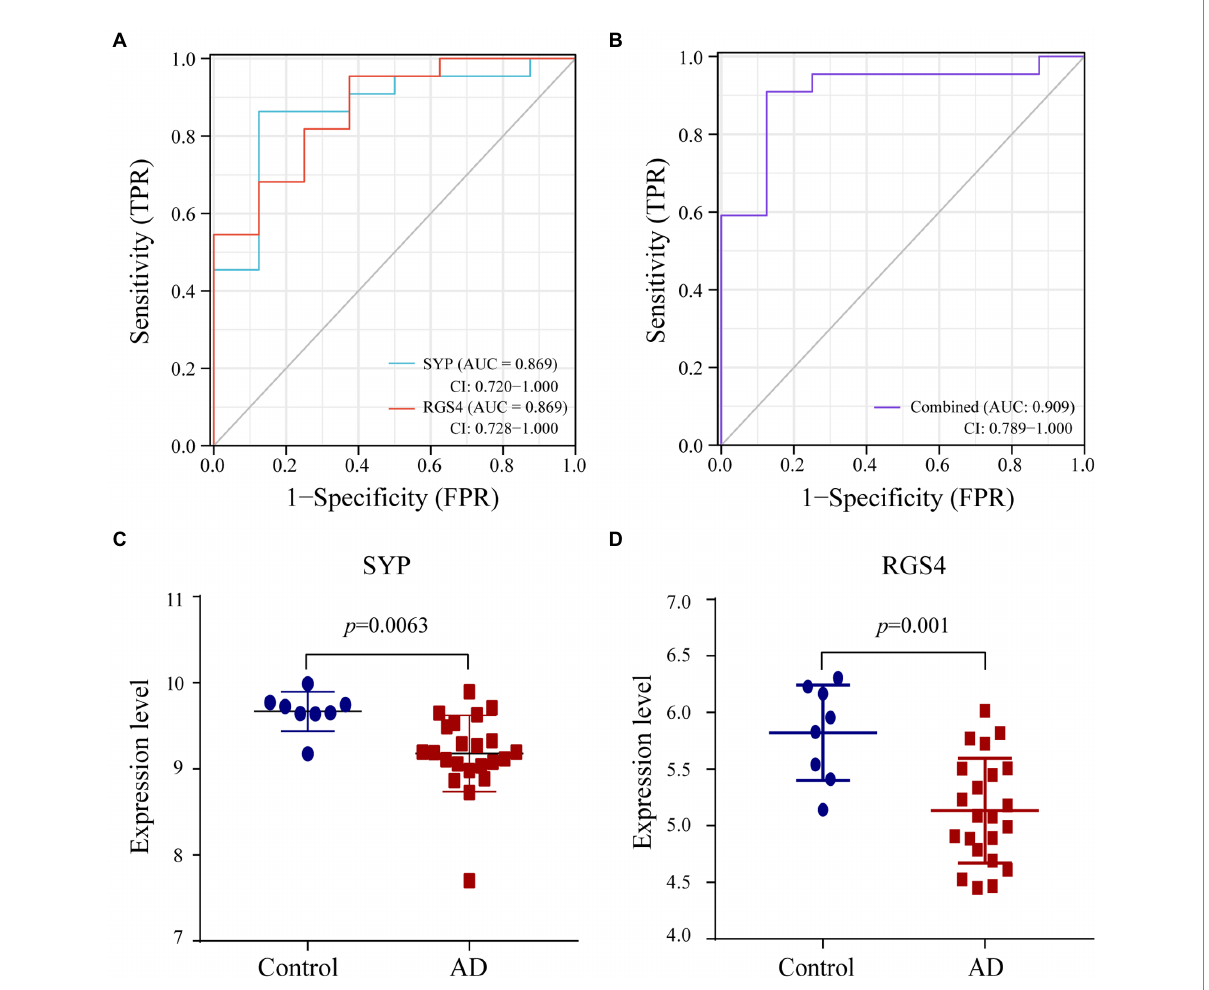
FIGURE 9 Verification of diagnostic markers. (A,B) The ROC curve of the diagnostic efficacy in verification set GSE28146. (C,D) The expression level of SYP and RGS4 in hippocampus between AD and control group from verification